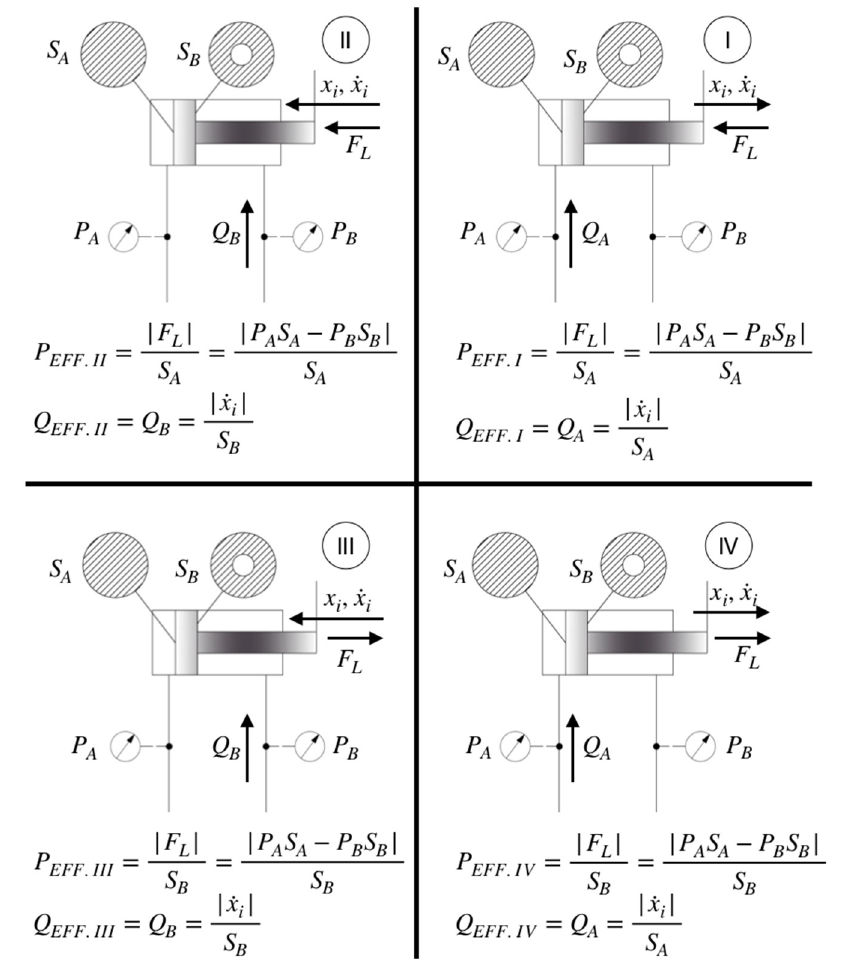
Figure A2. Effective pressure and flow in all quadrants for the extension actuator.